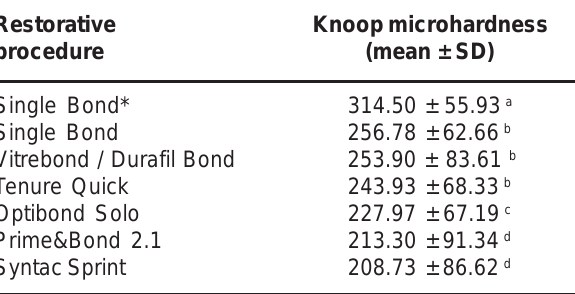
* Group did not subject to thermal and pH cyclings. Different letters indicate significant differences among groups (p<0.05).